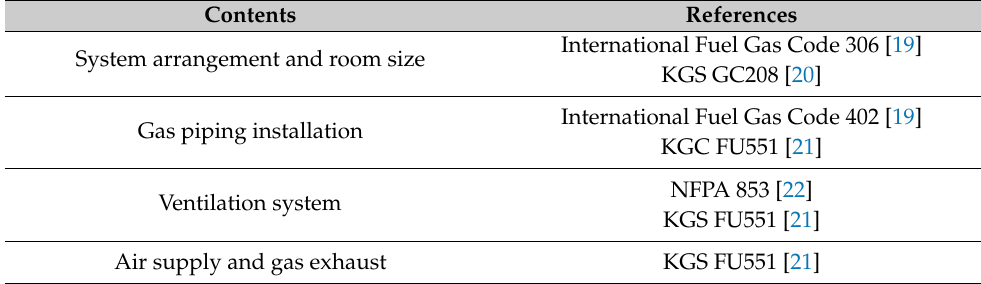
Table 1. Design and experimental codes for fuel gas rooms.